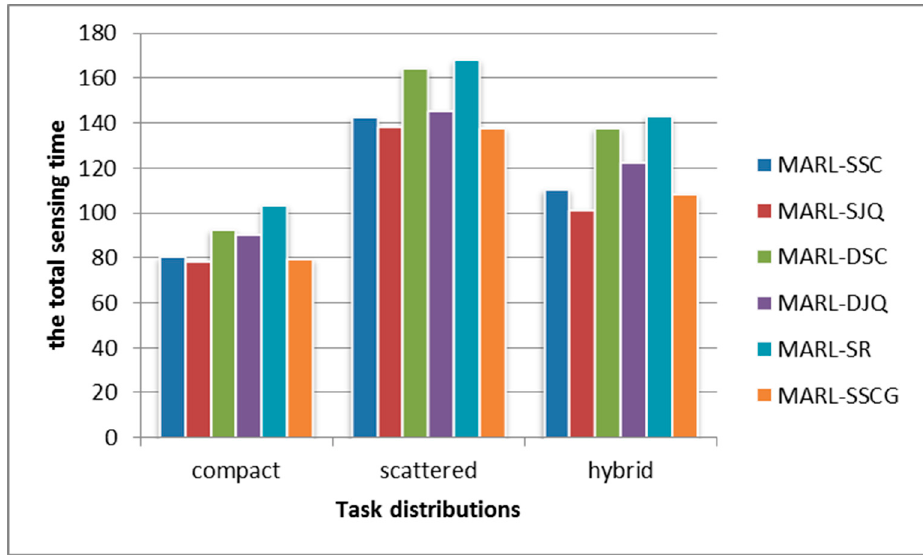
Figure 6. The total sensing time under different mobile sensing tasks distributions.